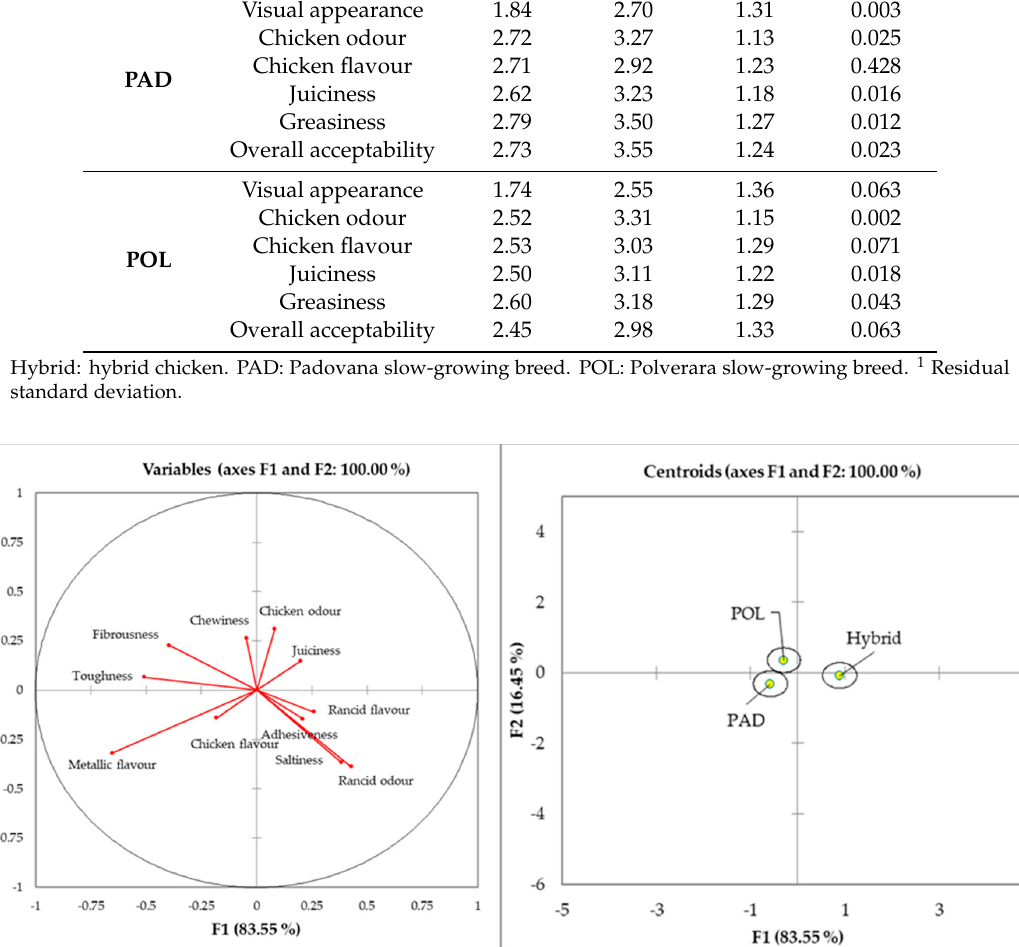
(b) Figure 2. (a,b) Discriminant analysis performed on the sensory data of the consumers’ panel. Hybrid: Hybrid chicken. PAD: Padovana slow-growing breed. POL: Polverara slow-growing breed. 4. Discussion The Padovana (PAD) and Polverara (POL) are local Italian chicken breeds, which have scarcely been selected for growth traits, thus showing moderate breast weights. Selective efforts instead have been mainly directed towards fixing certain morphological traits, in accordance with the “Registry of Italian Indigenous Chicken Breeds” (Ministerial Decree No. 19536 of 01.10.2014) [29]. Results of the present study showed that the average breast weight for both local breeds slaughtered at six months of age (i.e., their commercial slaughter age) was 117 g. This value is extremely low compared to conventional broiler hybrids, but also inferior compared to a previous research [18], which considered both male and female Padovana and Polverara chickens (average breast weight = 193 g). This finding indicates that the poor genetic selection for growth parameters in these local breeds can result in inhomogeneous productive outcomes, possibly being dependent on the considered chicken stock. This is exacerbated by the farming system, which exposes chickens much more to